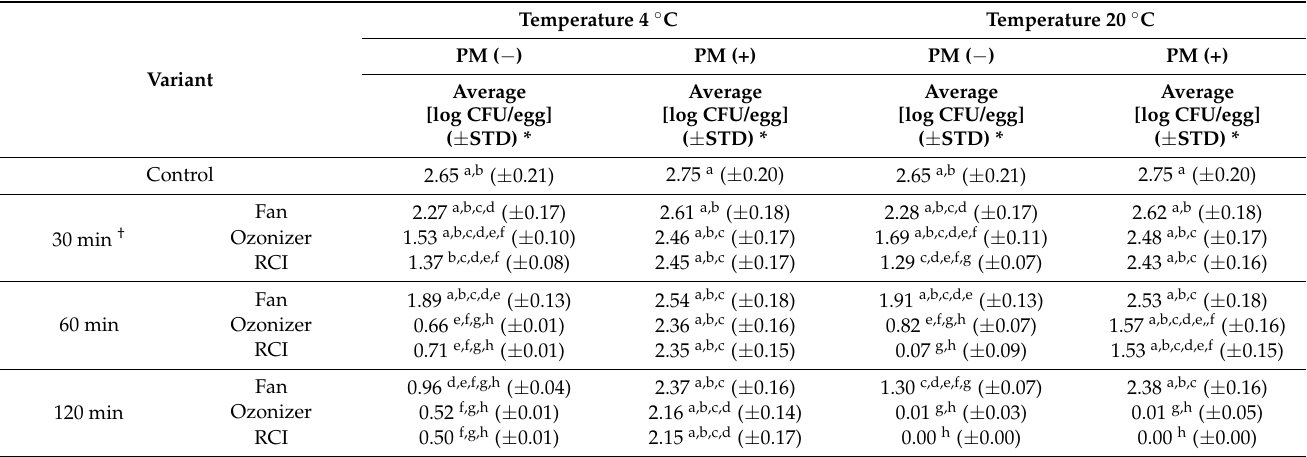
Table 3. The final number of Salmonella spp. on eggshells contaminated with bacterial suspension of 10 5 CFU/mL with or without the addition of poultry manure.